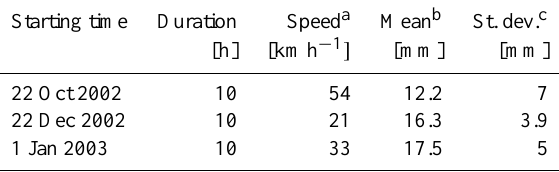
Table 1. Characteristics of three representative rainfall events. Starting time Duration Speed a Mean b St. dev. c